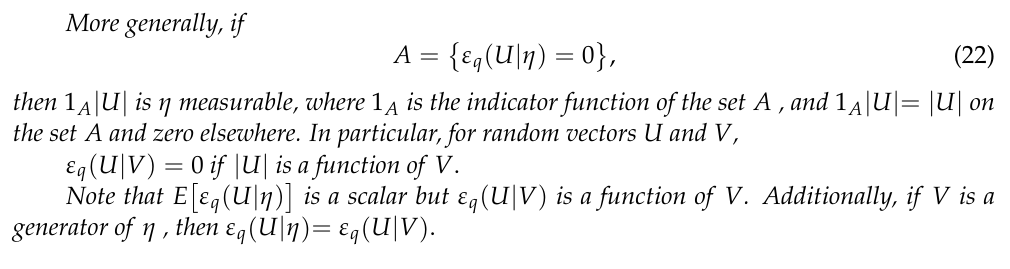
Figure 9. The fractional conditional cumulative residual entropy of